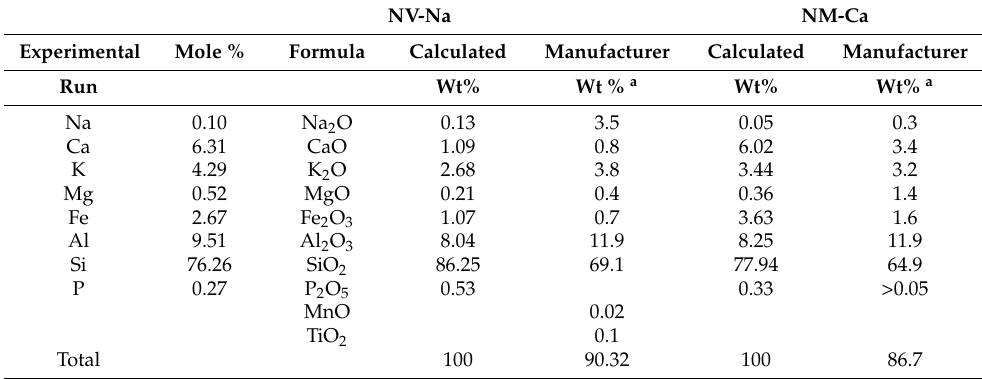
Table 4. The weight percentages from our calculated data and that of the